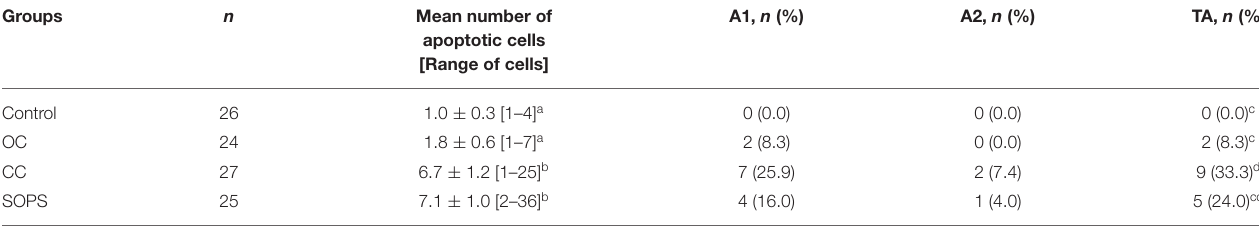
TABLE 2 | Results of the TUNEL assay of morulae and early blastocysts vitrified with open Cryotop ® (OC), closed Cryotop ® (CC) or SOPS systems. Groups n Mean number of